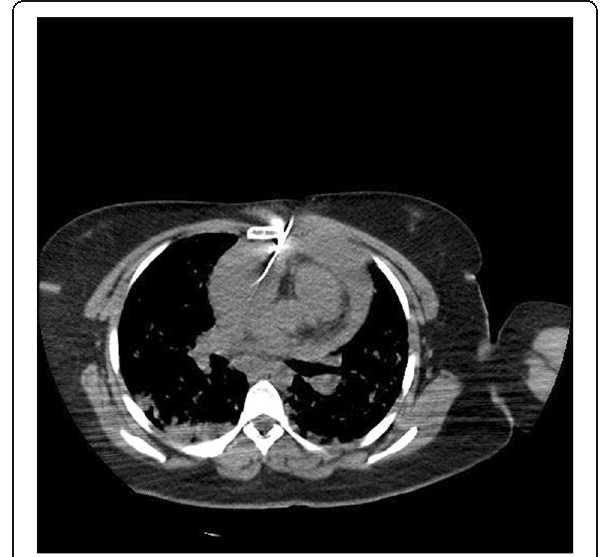
Fig. 4 Axial computed tomography scan of the thorax in the mediastinal window demonstrating transthoracic biospherical needles through the left parasternal intercostal space